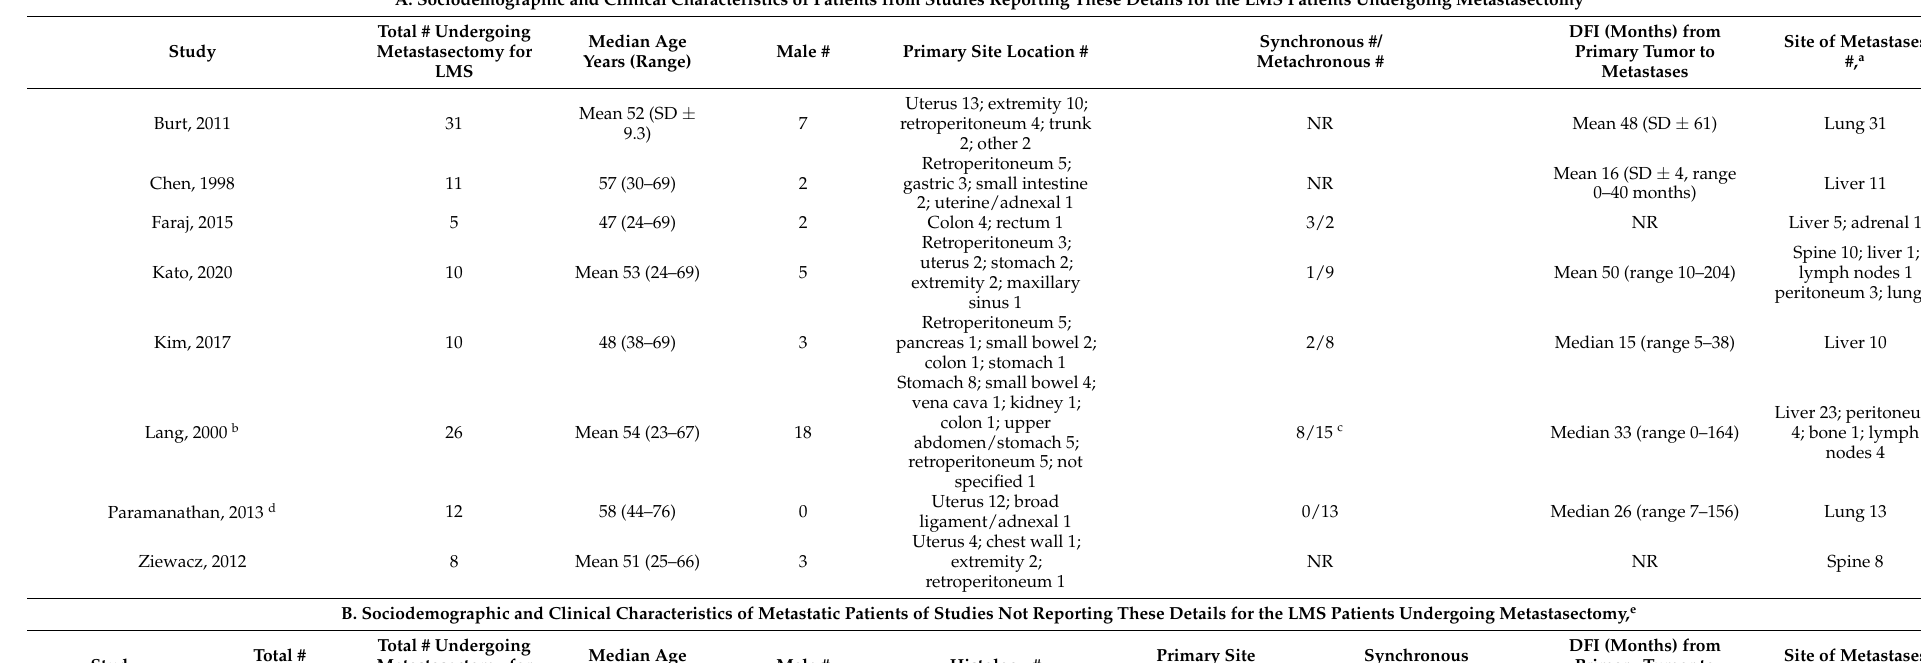
Table 2. Sociodemographic and clinical characteristics of included patients from studies reporting (A) and not reporting (B) these details for patients with LMS undergoing